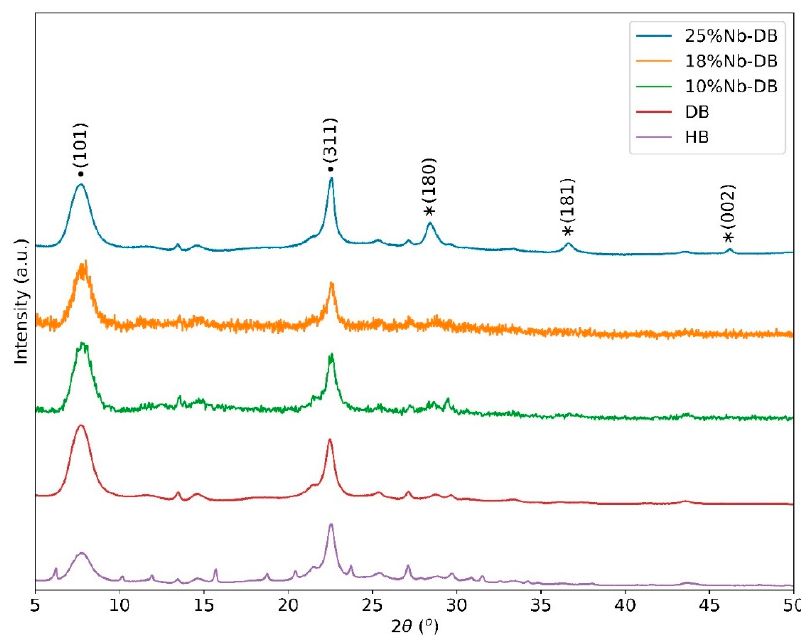
Figure 3. X-ray di ff raction patterns of the catalysts ( • refers to *BEA and * to T-Nb 2 O 5 ). Figure 3. X-ray diffraction patterns of the catalysts (•refers to *BEA and * to T-Nb 2 O 5 ). Table 3. Textural properties of the